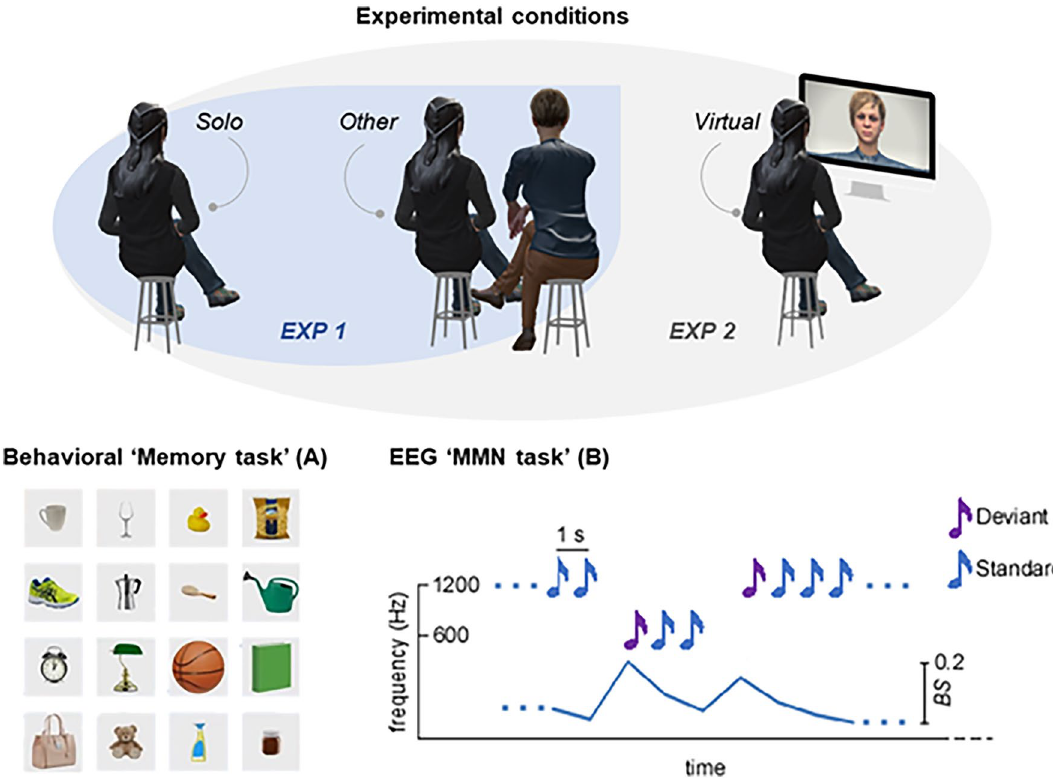
Figure 1. The top panel represents the experimental set-up across conditions in the two experiments. In Experiment 2, the screen used for the video-call was shown to the participant just before each experiment and seconds and then positioned next to the participants in the same position as in the Other condition (see “Stimuli and experimental design”). The left bottom panel represents the pictures employed in the memorization phase of the memory task. The right bottom panel represents Standard and Deviant auditory stimuli employed in the MMN roving paradigm. Human figures were created with the Adobe software Mixamo (https:// www. mixamo.